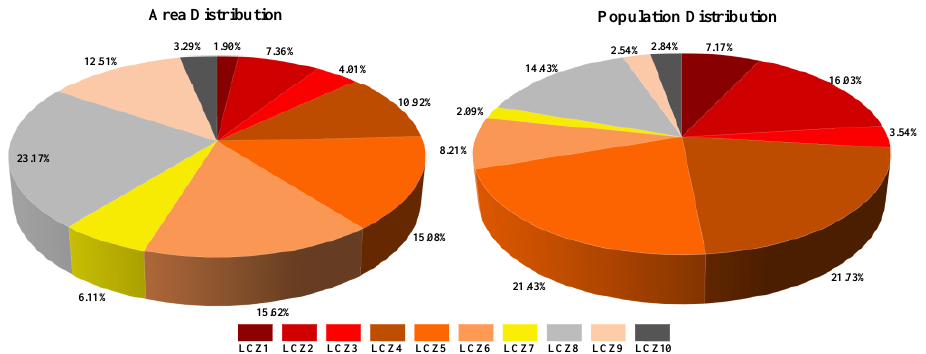
Figure 9. The proportions of area ( left ) and population ( right ) of the ten built-up classes (LCZ 1–10) for the 34 cities. A legend for the 3D colored pie chart is given at the bottom.